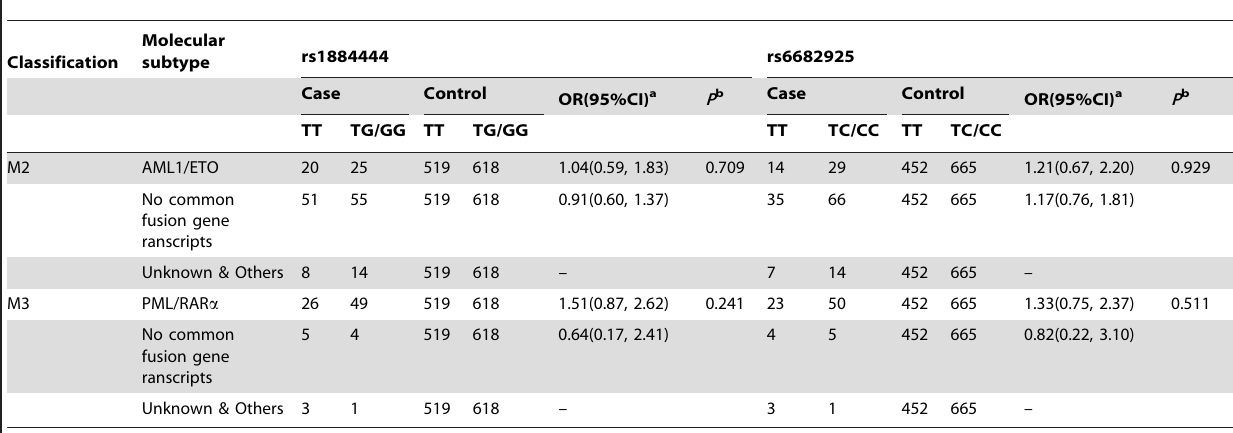
Table 4. Association of AML1/ETO and IL-23R Variants in M2 AML, and Association of PML/RAR a and IL-23R Variants in M3 AML.